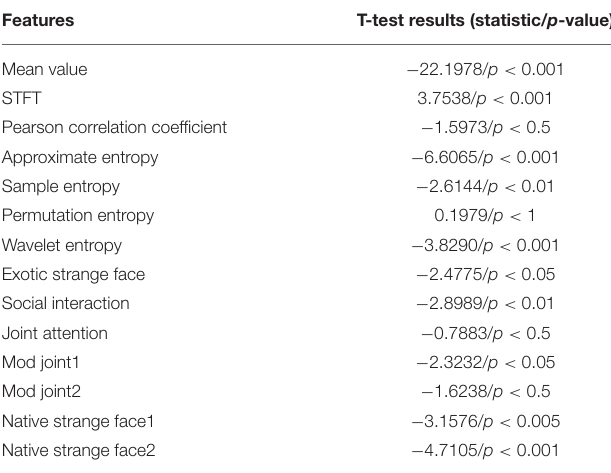
TABLE 1 | T-tests t-statistic values and corresponding p -value each feature.